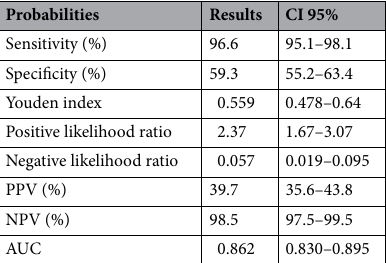
Table 3. Performance of the EU-TIRADS score in the diagnosis of thyroid cancer.